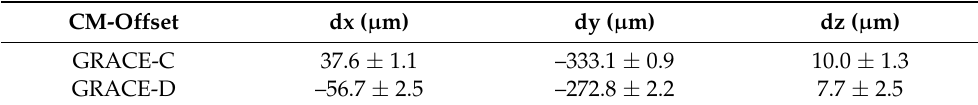
Table 8. Results of GRACE-FO satellites’ first CM-offset estimation.